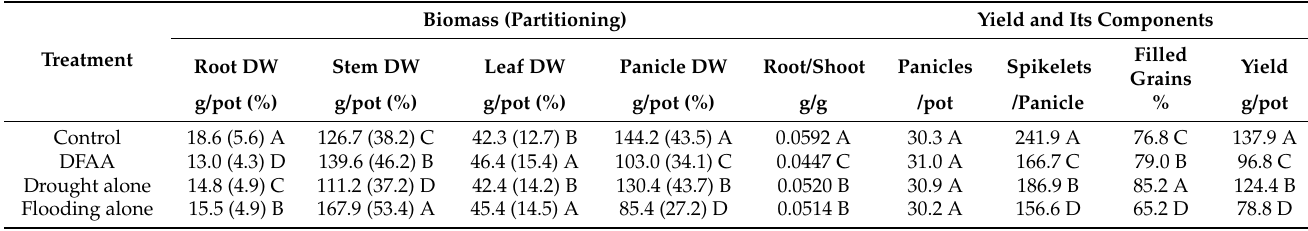
Table 2. Biological yield and its components of Longliangyouhuazhan (Indica hybrid cultivar) under different water stresses groups at